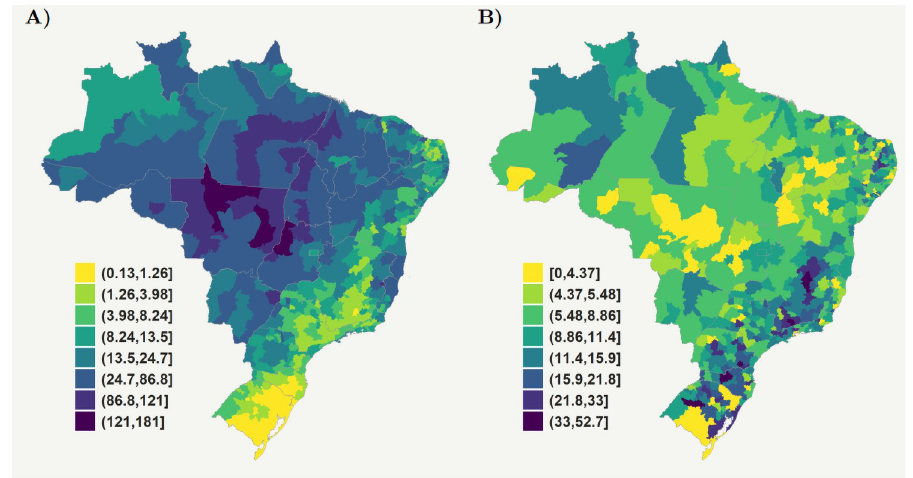
Fig 1. Brazilian microregions: (a) Observed leprosy incidence per 100,000 inhabitants in the period from 2007 to 2015; (b) Proportion of new leprosy cases diagnosed with Grade 2 of physical disabilities from 2007 to 2015. Similar plots at state level are presented in S1 Fig. Raw data are shown in this figure and available at https://github. com/cidacslab/Estimating-under-reporting-of-leprosy-in-Brazil.git [31]. We produced the maps using R software, geobr package [31, 32], (MIT license https://ipeagit.github.io/geobr/). period are concentrated in the North (42.95/100,000 inhabitants), Central-west (40.87/100,000 inhabitants) and Northeast (26.53/100,000 inhabitants) regions of Brazil. In the Central-West region, 46% were detected in Mato Grosso State. The states with the highest percentage of cases of G2D include Tocantins (12.33%), Maranh ã o (14.76%), Mato Grosso (12.06%), S ã o Paulo (8.37%) and Rio Grande do Sul (6.21%). From 2007 to 2015, all Brazilian states showed